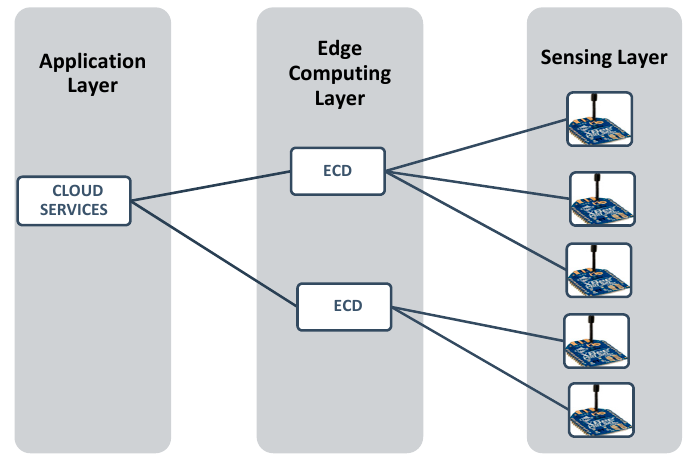
Figure 3. System architecture.